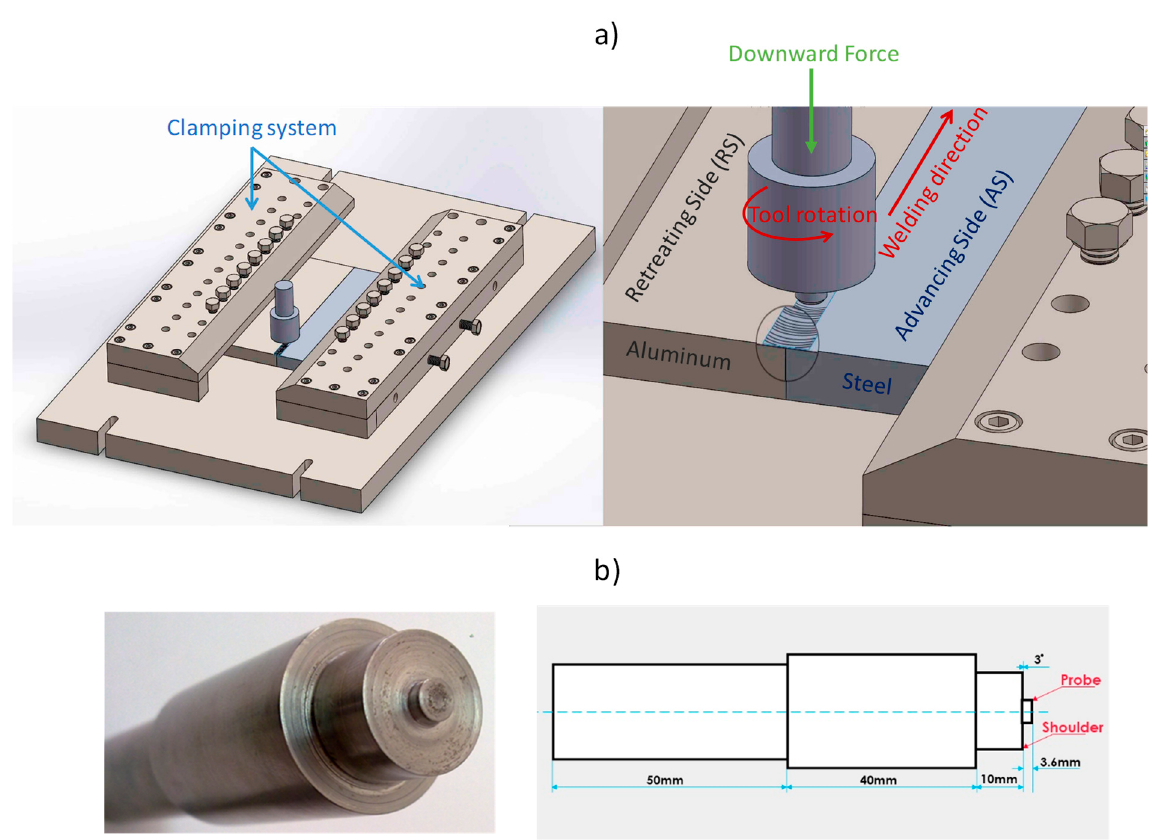
Figure 1. ( a ) Schematic illustration of the dissimilar friction stir welding (FSW) of aluminum and steel, and ( b ) photograph and dimensions of the FSW tool used in this work made from H13 tool steel.